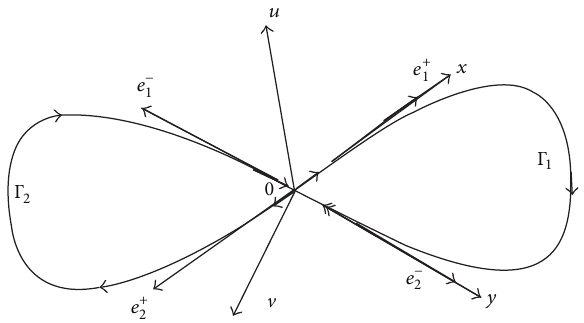
Figure 1: Double homoclinic loops Γ = Γ 1 ∪ Γ 2